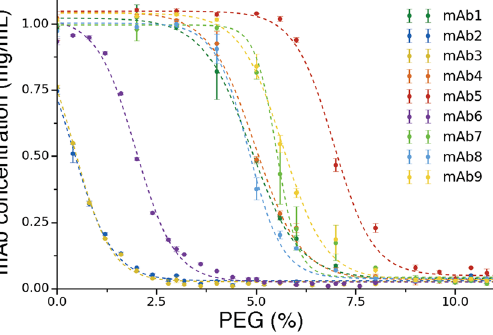
Figure 3. PEG-precipitation assay on the 9 mAbs targeting NGF analysed in this work. Plot of soluble mAb concentrations (y-axis) versus percent PEG amounts (weight/volume, x-axis). Data points are fitted with a sigmoidal curve (broken lines) and the value of the fitting parameter PEG 1/2 is used as a proxy for the solubility (see Methods and Figure S2).